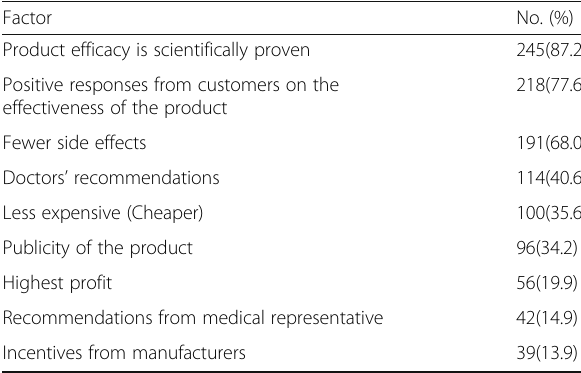
Table 2 Motivating factors reported by the pharmacists toward recommendations for complementary and alternative medicine